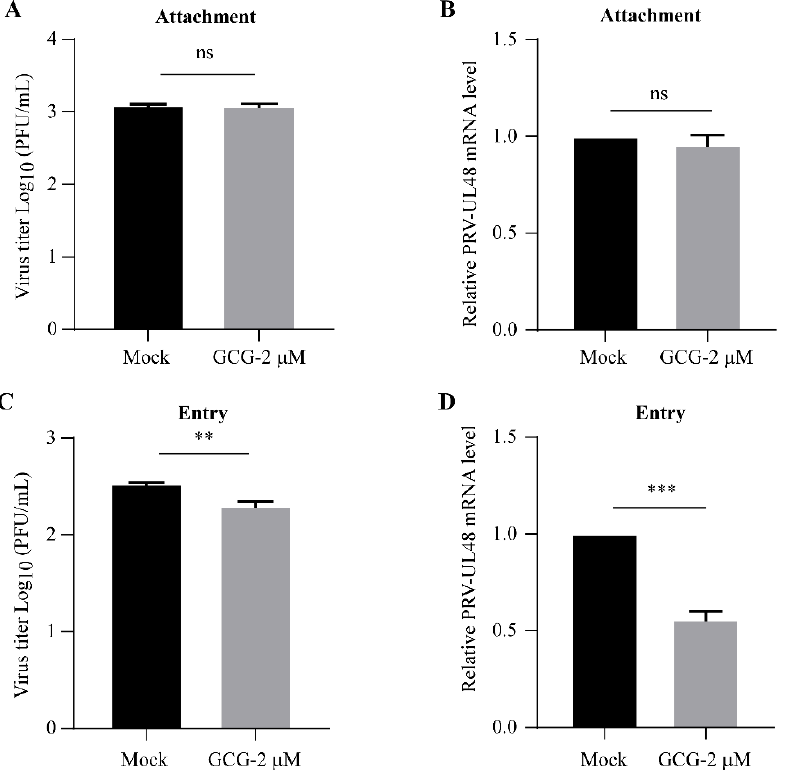
Figure 4. The entry stage in the PRV replication cycle was suppressed by gallocatechin gallate. ( A , B ) Gallocatechin gallate had no effect on the attachment stage in the PRV replication cycle. PK15 cells were pretreated with 2 μ M gallocatechin gallate for 2 h and then infected with JSY13 (5 MOI) for 1 h at 4 °C. The cell samples were washed with PBS three times, and the cells were collected using 1 mL DMEM and subjected to a plaque formation assay to measure the amount of PRV ( A ). Alterna- tively, the cells were also collected using TRIzol reagent, and the mRNA level of the PRV-UL48 gene was measured using a qPCR assay ( B ). ( C , D ) Gallocatechin gallate suppressed the entry stage in the PRV replication cycle. PK15 cells were infected with PRV (5 MOI) and incubated at 4 °C for 1 h, then the cells were treated with gallocatechin gallate (2 μ M) at 37 °C for 1 h. The cells were washed with cold sodium citrate (pH 3.0) three times and then washed with PBS three times. The cells were col- lected with 1 mL DMEM, and the total amount of PRV was measured using a plaque formation assay ( C ). Alternatively, the cells were also collected using TRIzol reagent, and the mRNA level of the PRV-UL48 gene was measured using a qPCR ( D ). (ns, not significant; **, p < 0.01; ***, p < 0.001).